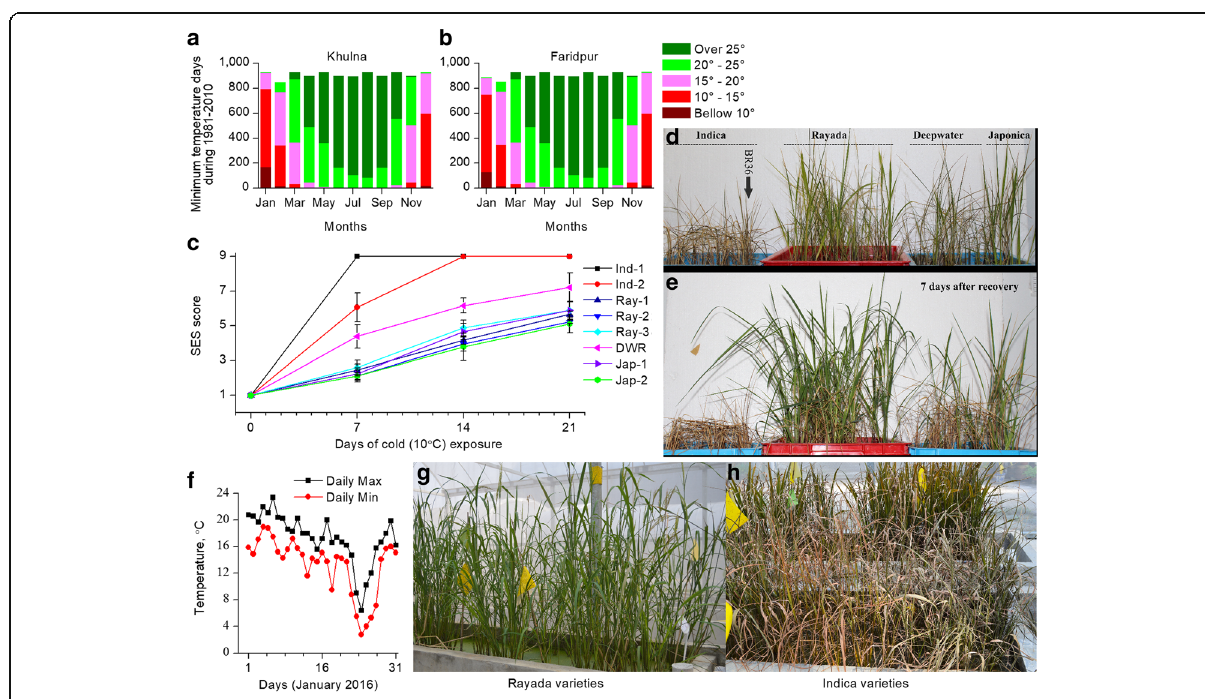
Fig. 10 Extent of cold tolerance of Rayada rice, a Bangladesh confined deepwater rice ecotype. a - b Minimum temperature days at the two weather stations, neighboring Rayada rice growing areas, a Khulna, b Faridpur, Bangladesh, c - e Comparative cold tolerance of different rice varieties conducted in growth chamber, c SES score, d Representative phenotypes after prolong cold exposure (continuous 21 days of 10 °C), e Representative phenotypes 7 days after recovery at 28 °C, f - h Comparative cold tolerance at field conditions, f Temperature profile at the experimental site during January 2016, collected from the nearest automated weather station. g Representative phenotypes of Rayada varieties 7 days after the cold-wave, h that of the Indica varieties. Ind 1, 2 and Jap 1, 2 represent BR 11, BRRI 36, Donjgin, Nipponbare, respectively